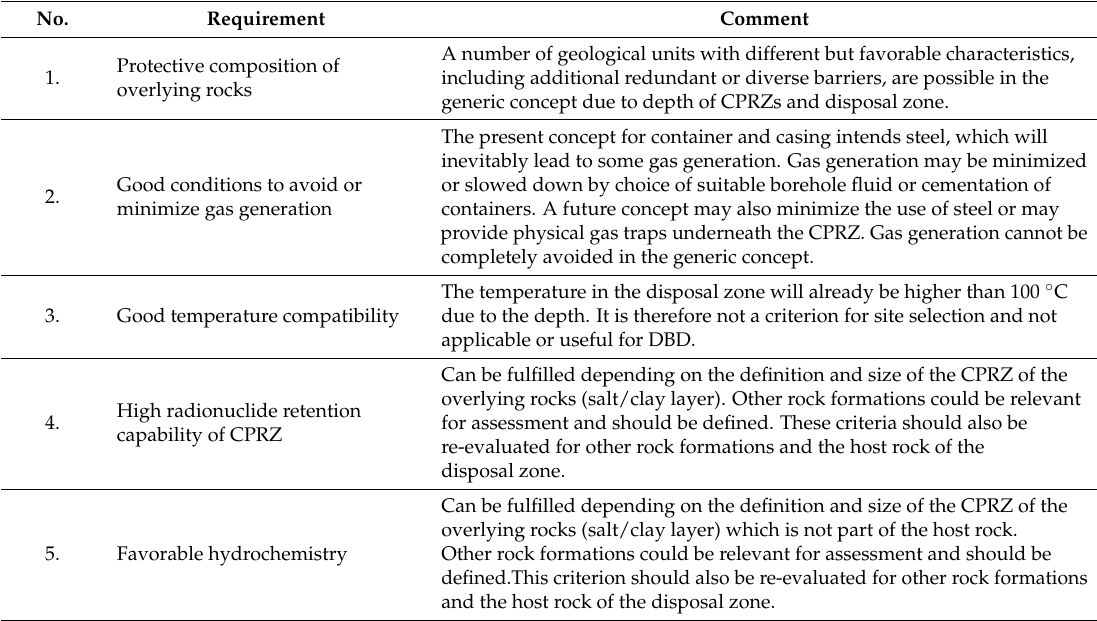
Table 4. Weighting group 3: Further safety relevant